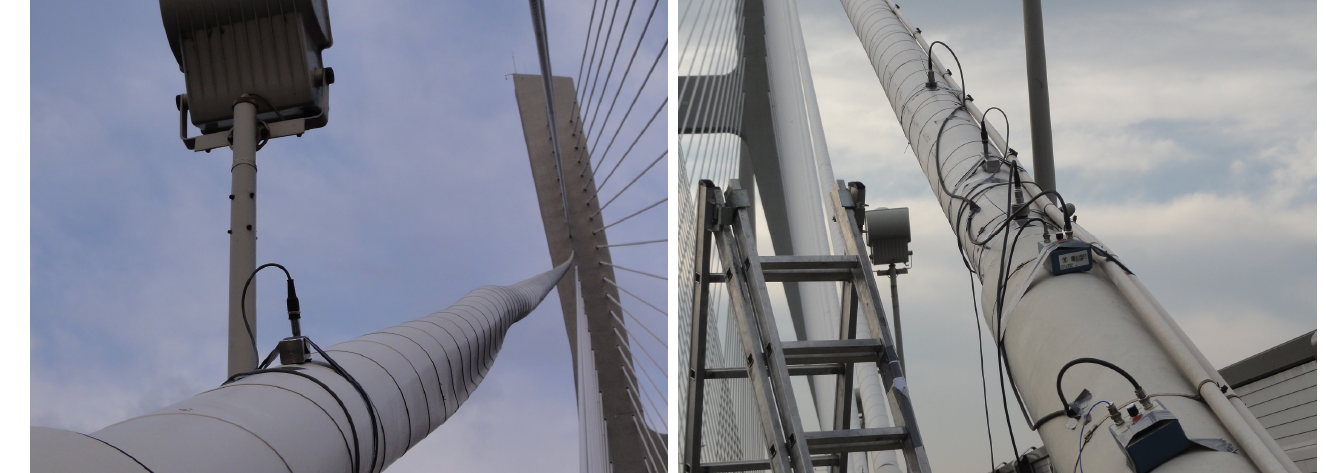
26 of 29 Figure 22. LZ-W11 cable sheath deformed as a result of a vehicle fire. An alternative method that can be used for the determination of a stay cable force are dynamic measurements by using, e.g., external accelerometers. The potential of this method is a subject of the Polish–Portuguese NAWA-FCT research project “Dynamic monitoring of bridge structures”, supported by the Polish National Agency for Academic Exchange and Fundação para a Ciência e a Tecnologia in Portugal, that is carried out,